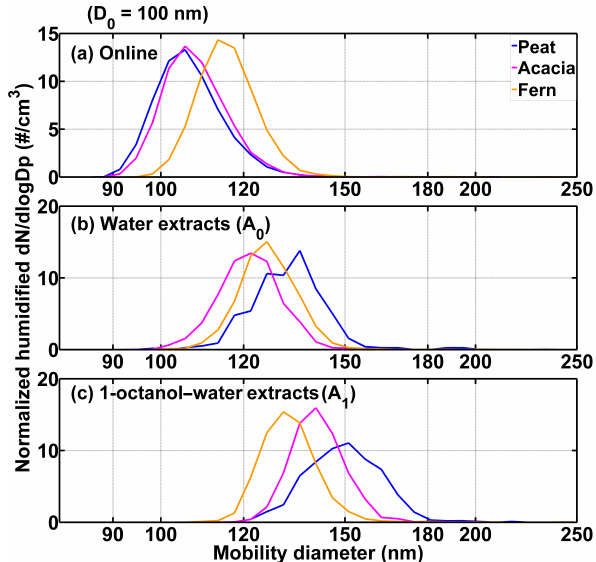
Figure 2. Normalized number size distributions measured by the HTDMA ( D 0 = 100nm; RH = 90%) of peat, fern, and acacia burn- ing particles. (a) Online data, (b) A 0 , and (c) A 1 . For online data, peat burning particles are nearly non-hygroscopic, while fern burn- ing particles are more hygroscopic. Aqueous extracts of peat burn- ing particles are the most hygroscopic among the three types of biomasses. The x axis is on a logarithmic